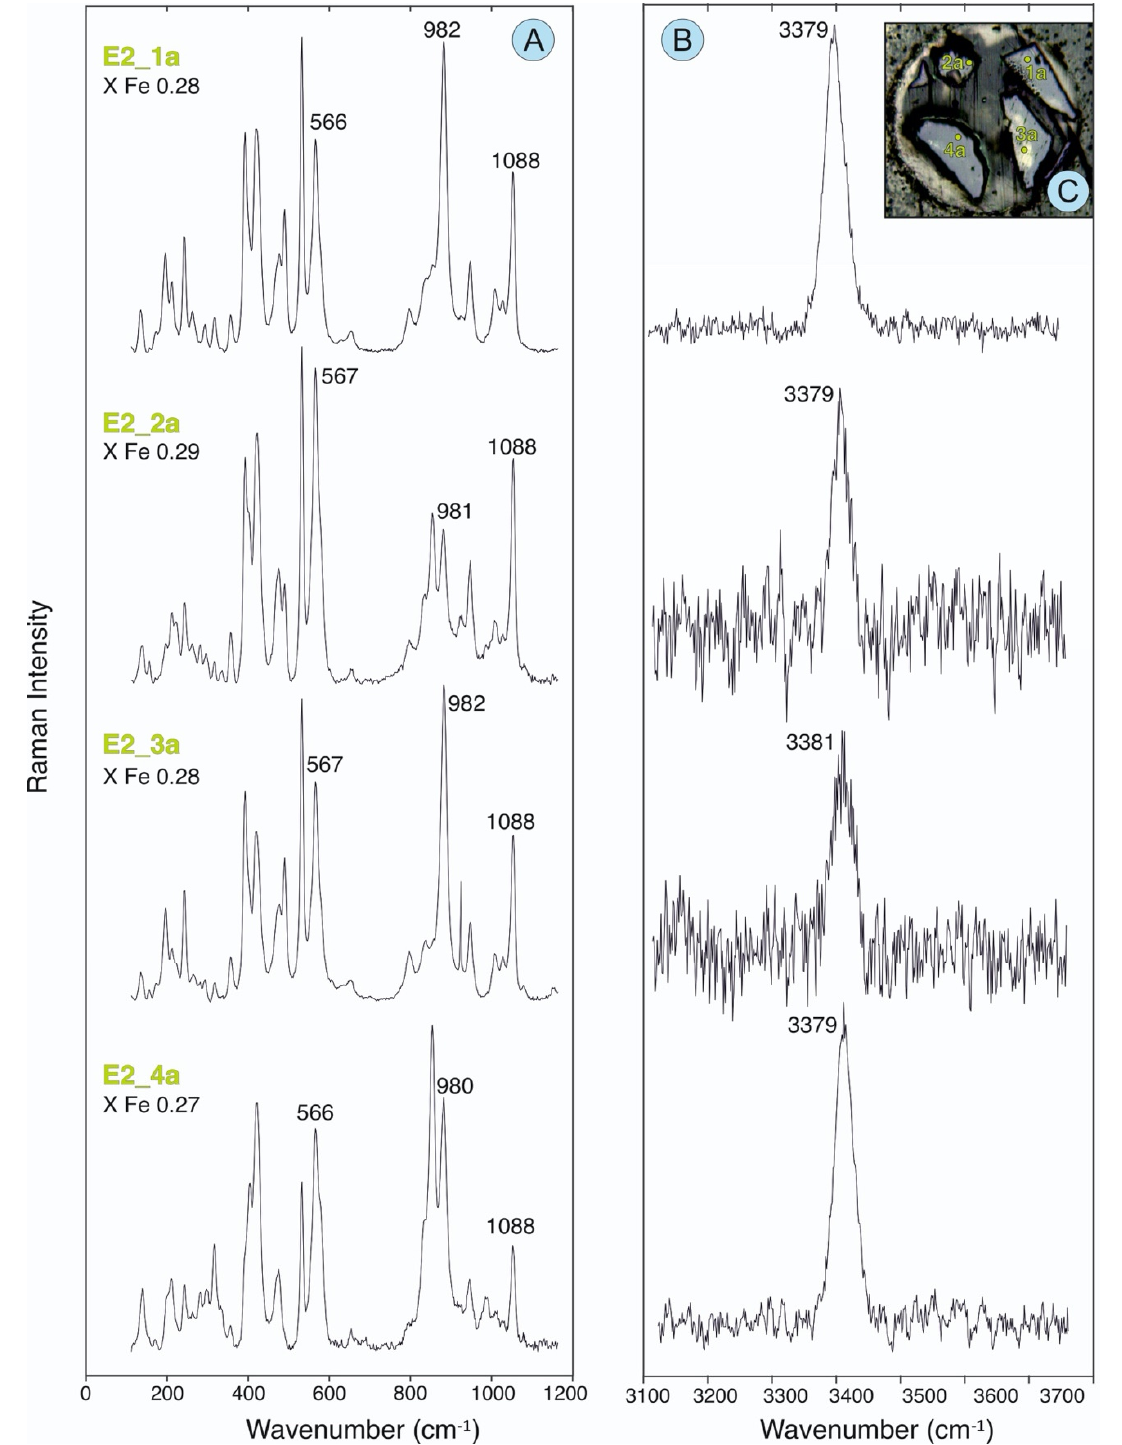
Figure 2. Characterization of epidote standard E2. Raman spectra in the low-frequency ( A ) and high-frequency ( B ) regions. ( C ) Map of the analyzed points in four crystal fragments (note the minor variability in the positions of the Raman peaks and of the X Fe values determined by SEM–EDS).